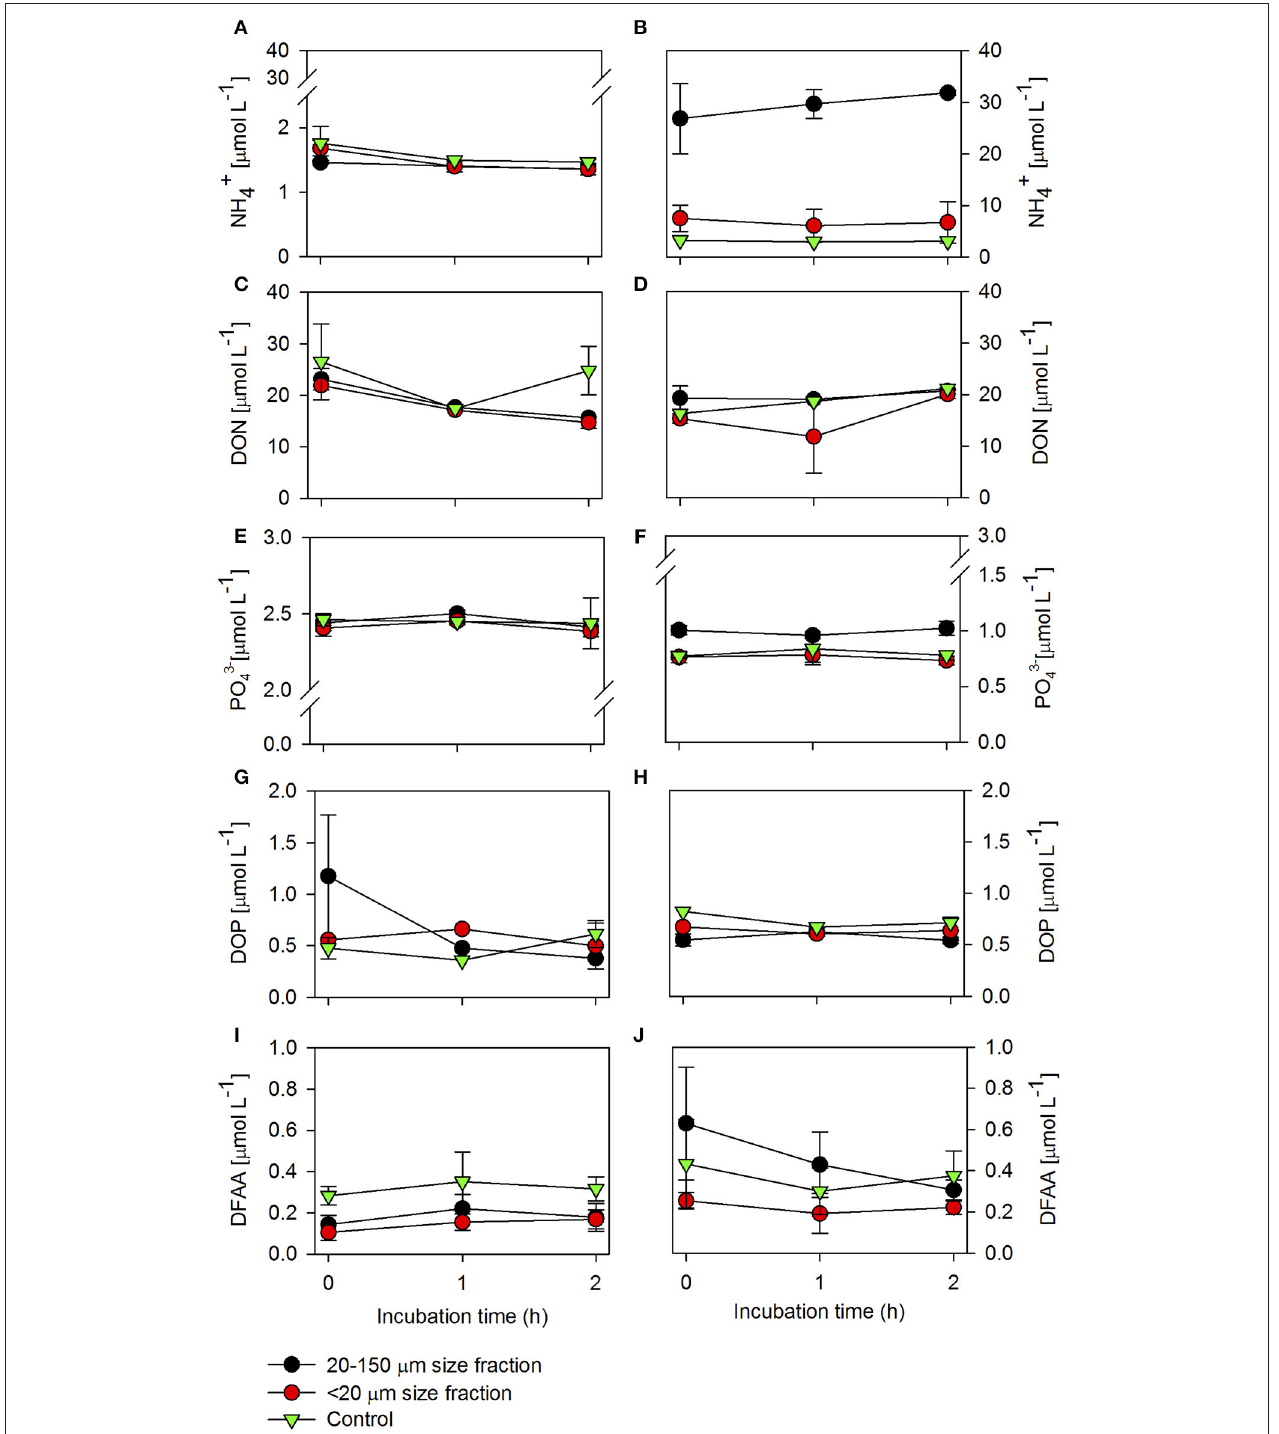
FIGURE 1 | Ammonium (NH + 4 ) (A,B) , dissolved organic nitrogen (DON) (C,D) , phosphate (PO 3 − 4 ) (E,F) dissolved organic phosphorus (DOP) (G,H) , and dissolved free amino acid (DFAA) (I,J) concentrations throughout incubation in the excretion phase for both treatments and controls in late summer and spring. Errors bars show the standard deviation ( n =